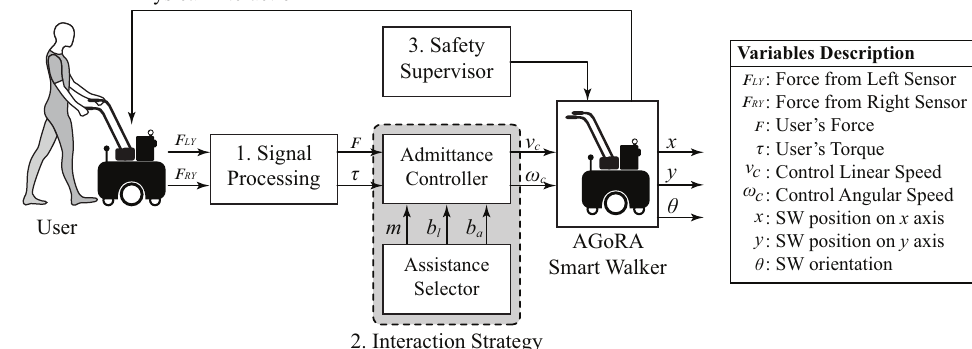
Figure 2. Description of system’s architecture to provide multiple assistance